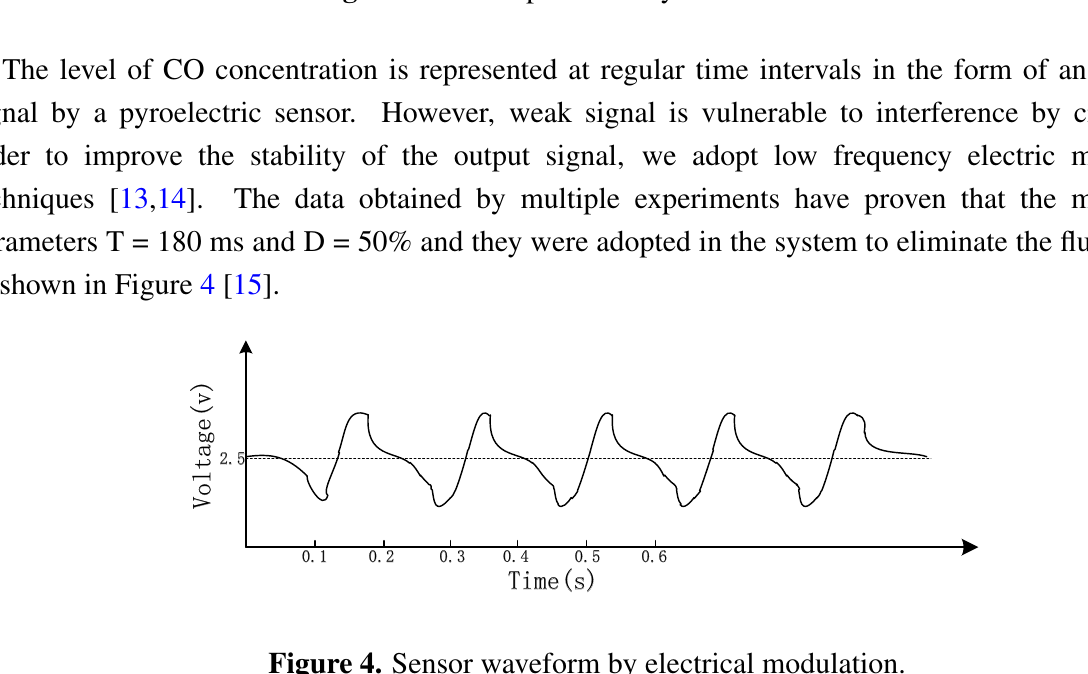
Figure 3. Actual picture of system hardware.